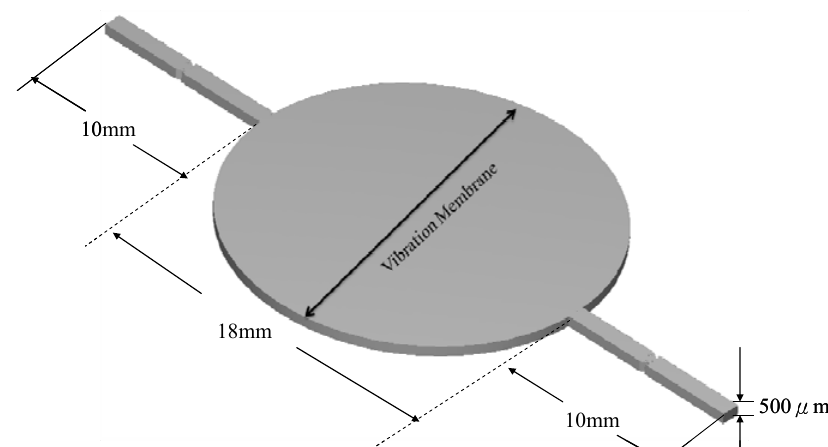
Figure 2. Three dimensional schematics of the NMPV micro-pump